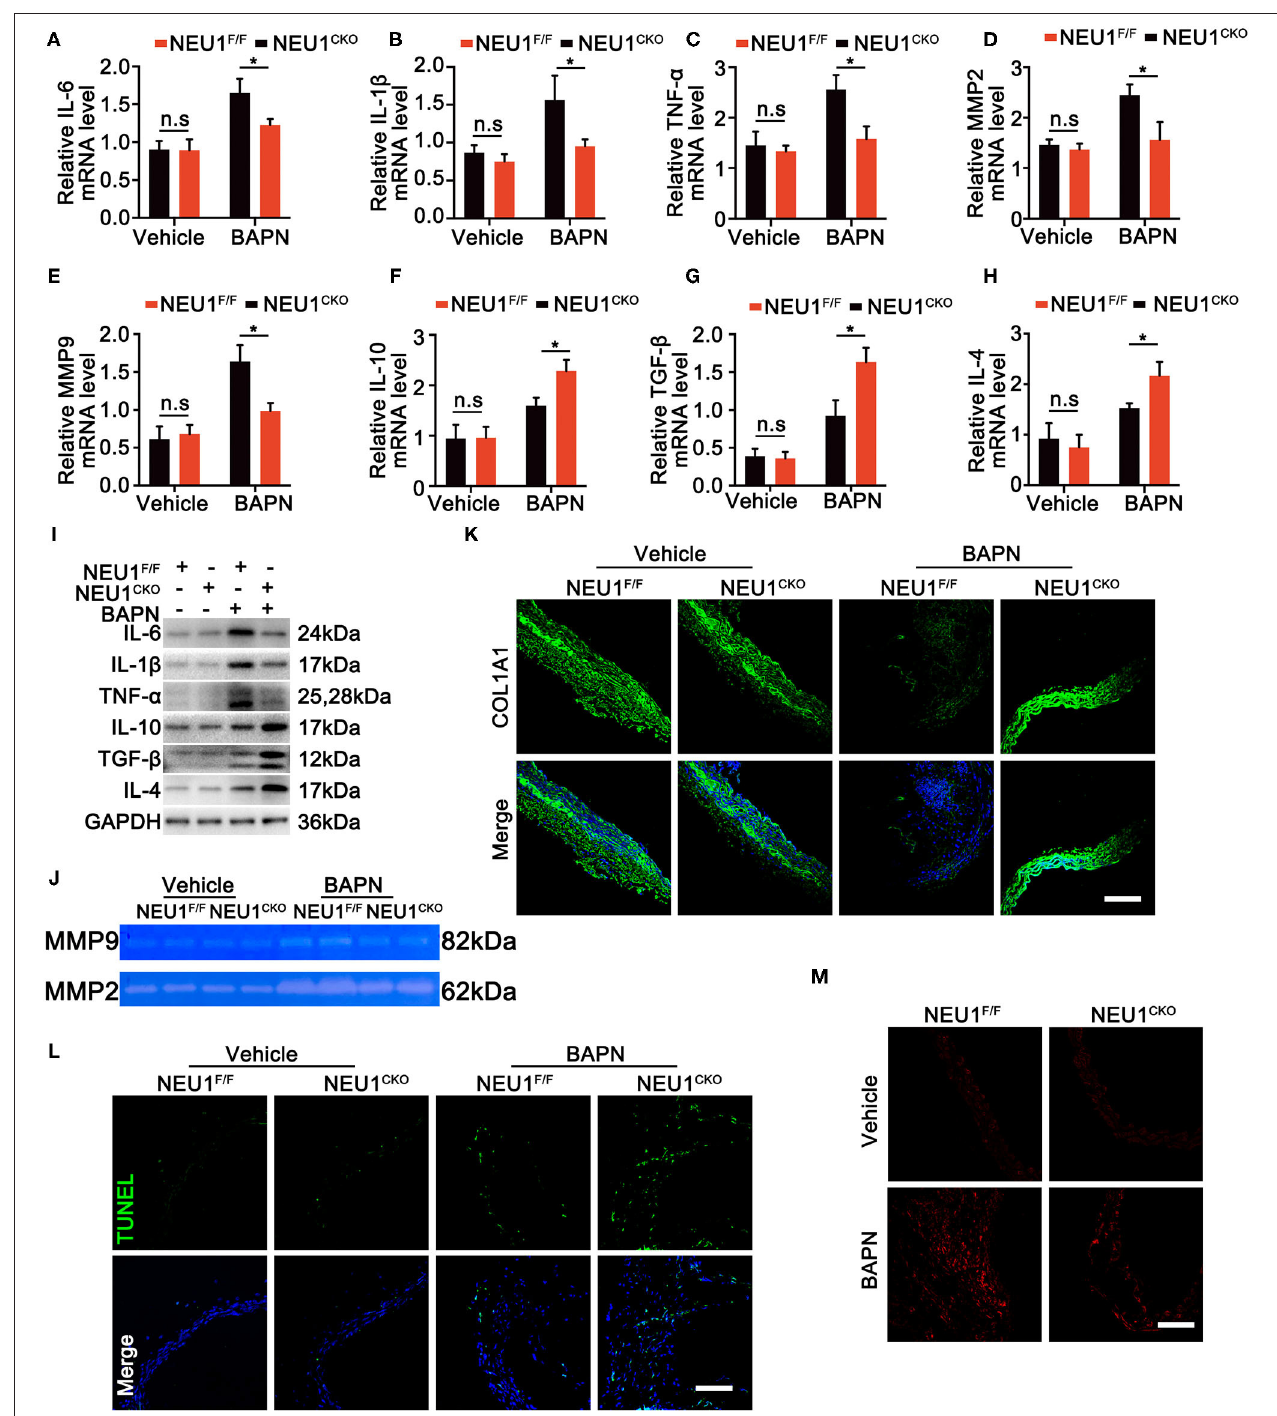
FIGURE 4 | NEU1 depletion suppressed BAPN-induced inflammation. (A–H) Quantitative mRNA levels of pro- and anti-inflammatory factors in aortas of NEU1 F / F and NEU1 CKO mice subjected to BAPN induction for 4 weeks ( n = 6 per group). (I) Representative western blots of pro- and anti-inflammatory factors in aortas of NEU1 F / F and NEU1 CKO mice subjected to BAPN induction for 4 weeks ( n = 6 per group). (J) Gelatin zymogram analysis of MMP2 and MMP9 activity levels in aortas of NEU1 F / F and NEU1 CKO mice subjected to BAPN induction for 4 weeks. (K) Immunofluorescence images of COL1A1 in aortas of NEU1 F / F and NEU1 CKO mice subjected to BAPN induction for 4 weeks (scale bar: 50 µ m). (L) TUNEL staining of aortas from NEU1 F / F and NEU1 CKO mice subjected to BAPN induction (scale bar: 50 µ m). (M) DHE staining of aortas from NEU1 F / F and NEU1 CKO mice subjected to BAPN induction for 4 weeks (scale bar: 50 µ m). BAPN, β -aminopropionitrile monofumarate; DHE, dihydroethidium; KO, knockout; MMP, matrix metalloproteinase; NEU1, neuraminidase 1; NEU1 CKO, macrophage-specific NEU1 knockout. * p < 0.05.